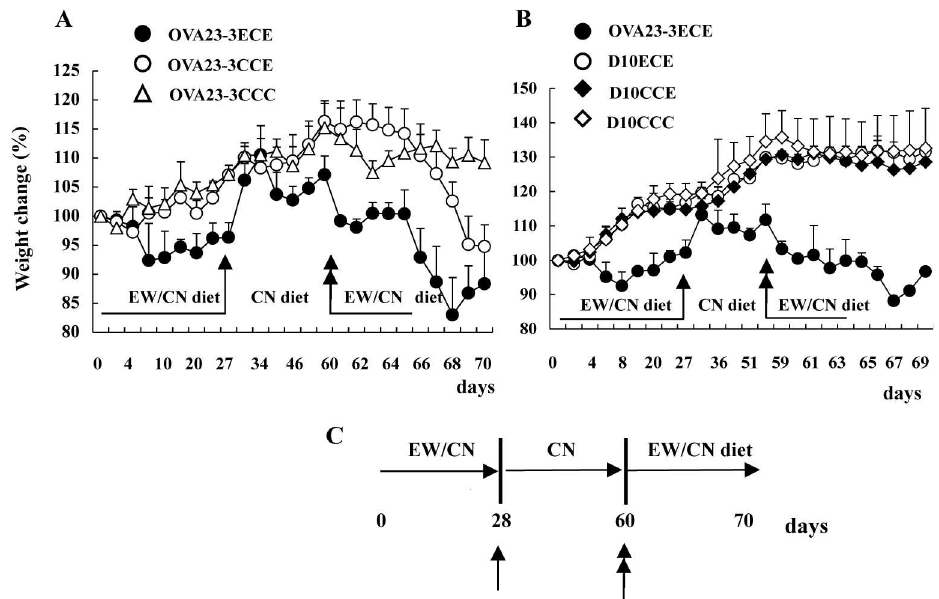
Fig 7. Weight changes of EW-re-fed OVA23-3 mice after given the control-diet for 1 month. A , Weight changes(relative to day 0 [100%]) of OVA23-3ECE mice (re-administration of EW diet after 1-month interval of CN diet; diet throughoutexperimental period, EW ! CN ! EW diet; ● , n = 3), OVA23-3CCE mice (started EW diet on day 60; diet throughout experimental period: CN ! CN ! EW diet; (cid:14) , n = 3), and OVA23-3CCC mice (receivedcontrol [CN] diet throughout experimental period, CN ! CN ! CN diet; 4 : n = 2). B , Weight changesof OVA23-3ECE ( ● , n = 2), D10ECE ( (cid:14) , n = 3), D10CCE( ◆ , n = 3), and D10CCC( (cid:5) , n = 3) mice. C, Protocol for re-administratingEW diet ( " , changefrom EW diet to CN diet on day 28; "" , re-administration of EW diet on day 60). These data are representative of two independentexperiments.